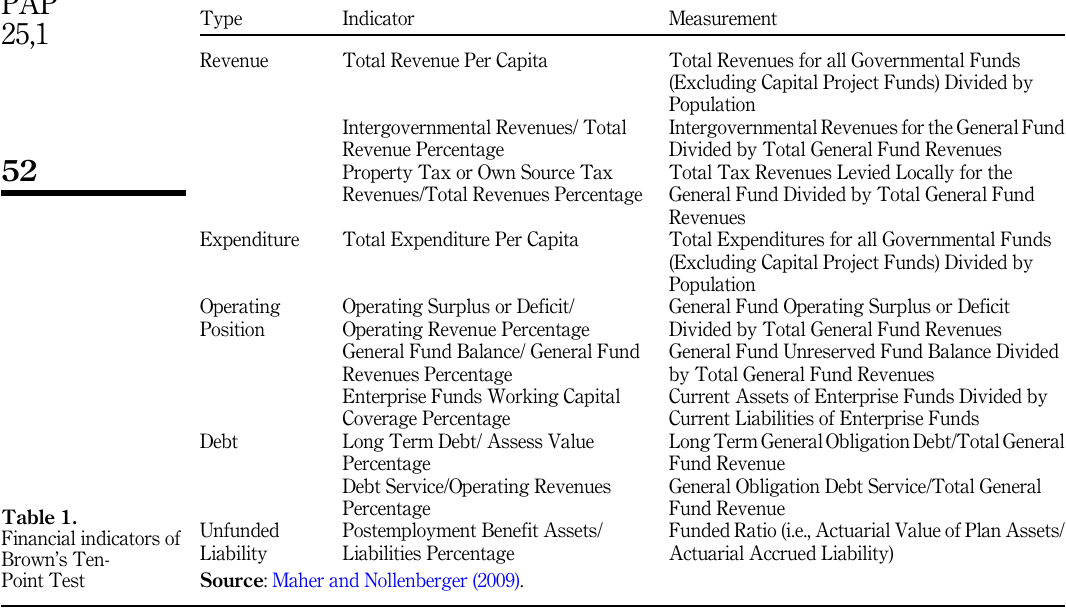
Table 1. Financial indicators of Brown ’ s Ten- Point Test